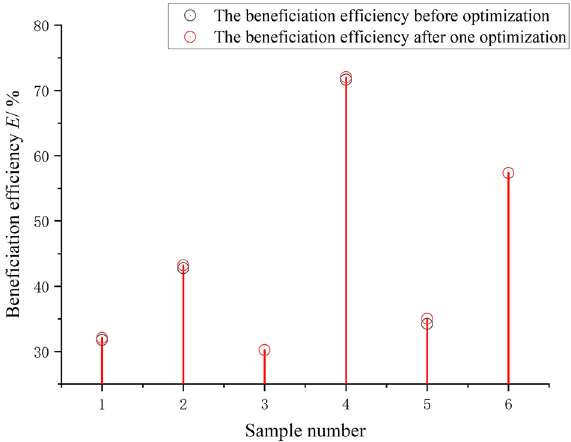
Figure 16. The fluctuation of beneficiation efficiency after one